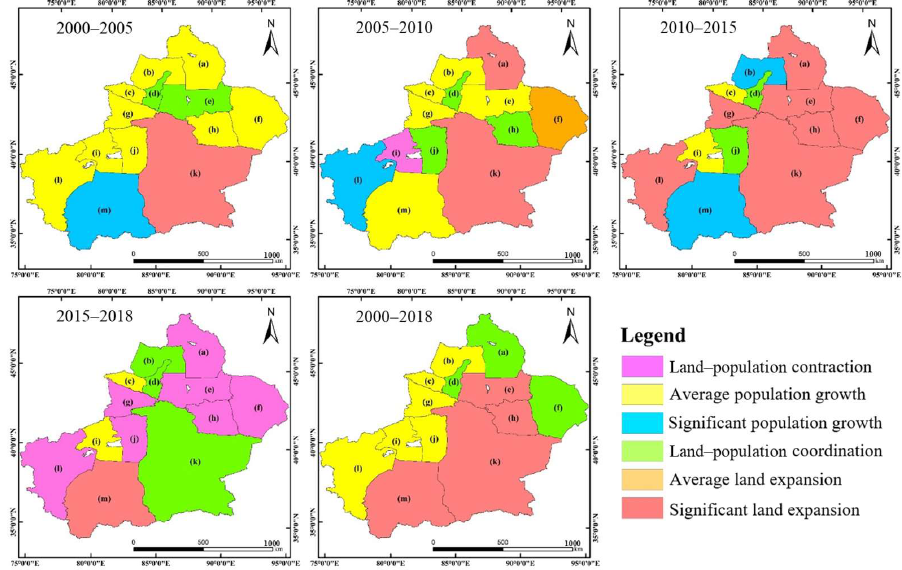
Figure 4. Assessment of the coordination between construction land expansion and